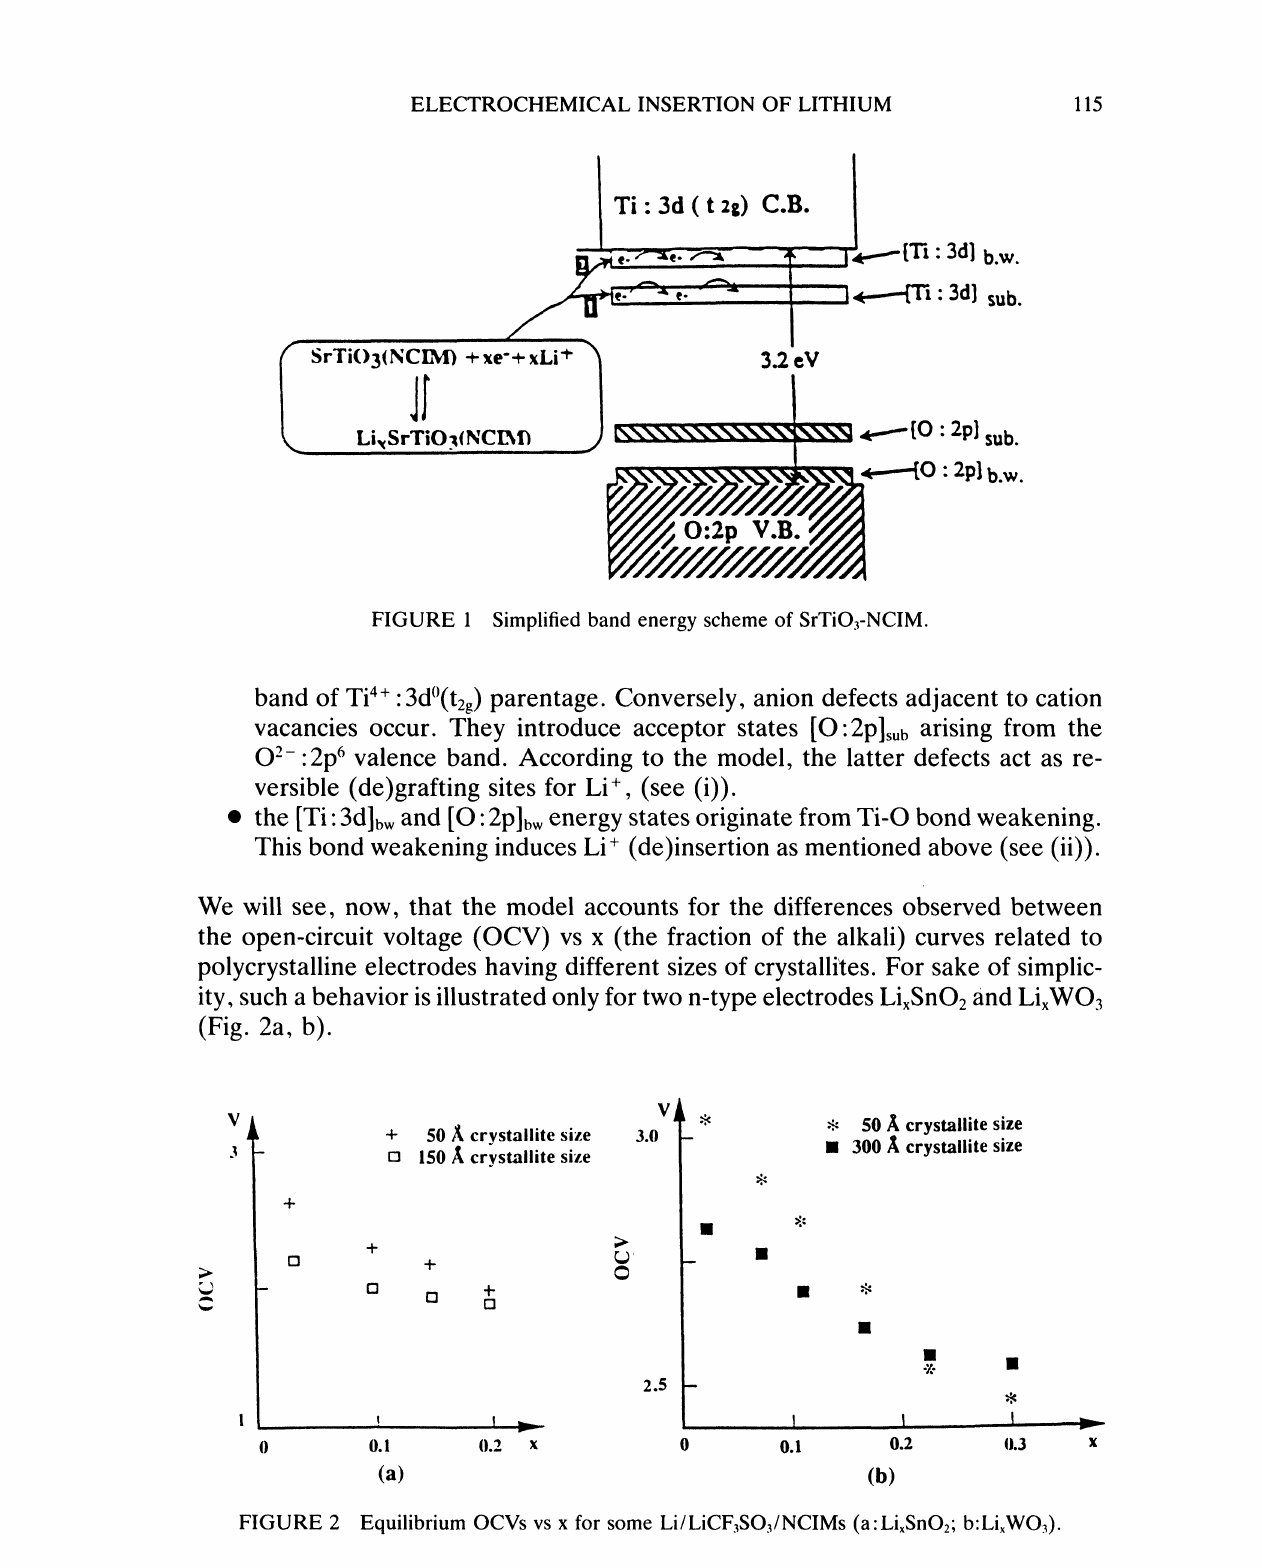
FIGURE 2 Equilibrium OCVs vs x for some Li/LiCF3SO3/NCIMs (a’LixSnOz;